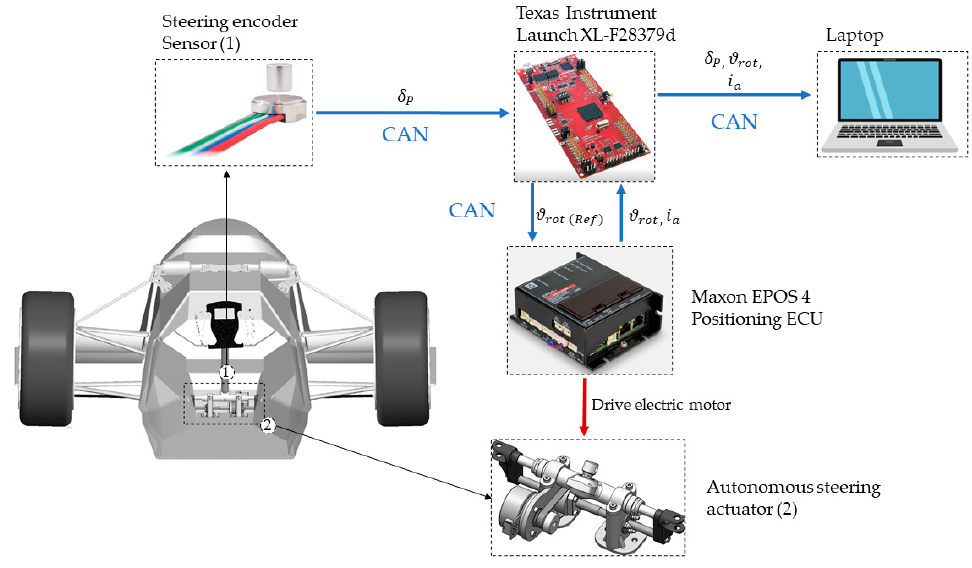
Figure 5. Autonomous steering actuator testbed setup block scheme.